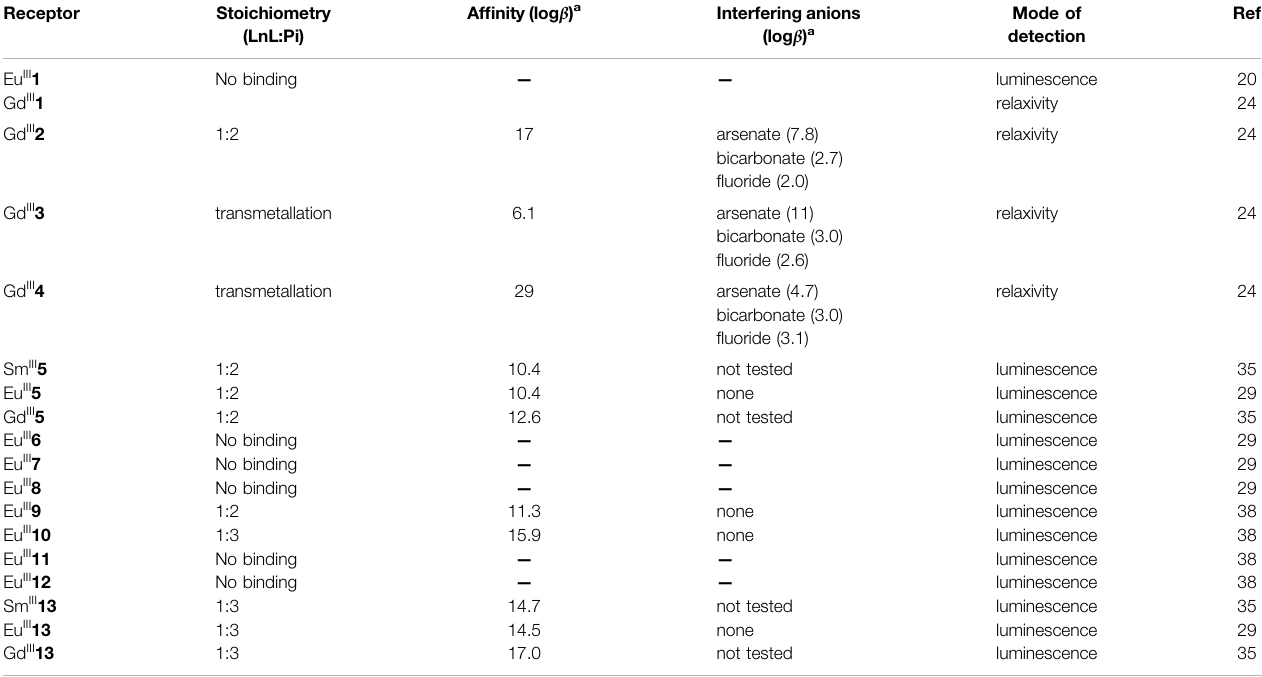
TABLE 1 | Inorganic phosphate ternary complex stoichiometry, af fi nity, selectivity, and mode of detection for phosphate receptors. Receptor Stoichiometry Af fi nity (log β ) (LnL:Pi)